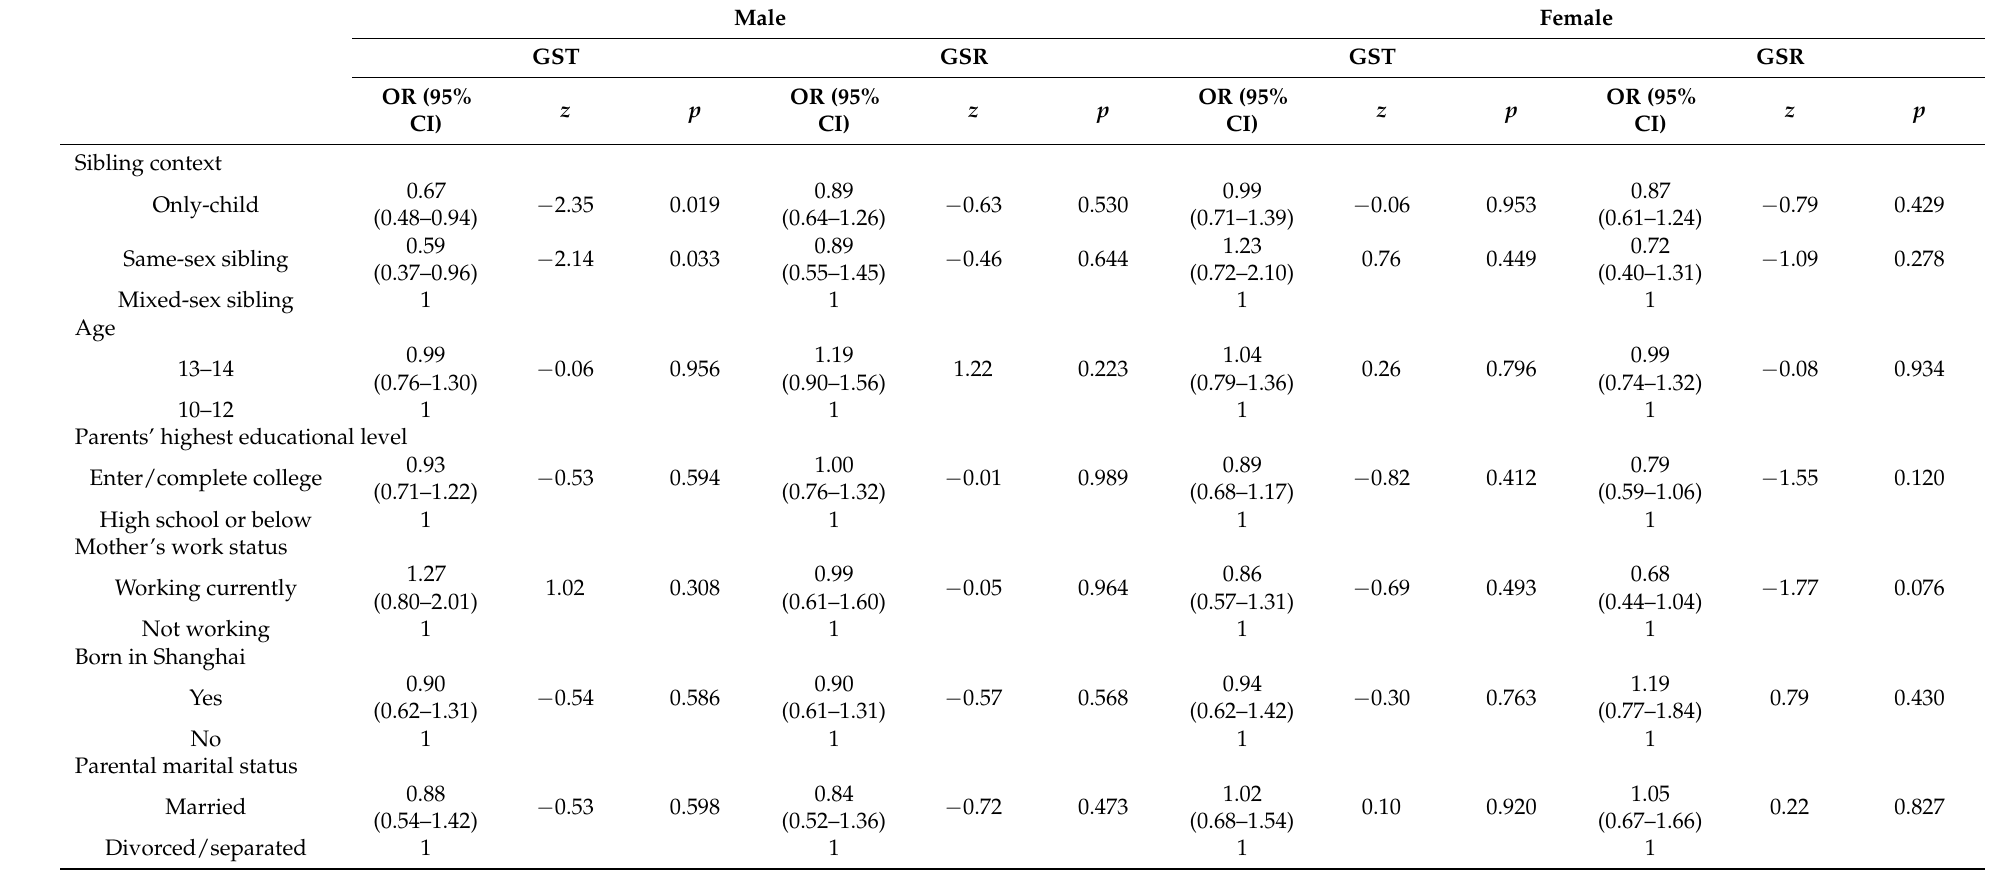
Table 5. Ordinal logistic regression testing sibling context on two gender norm scales’ scores, stratified by